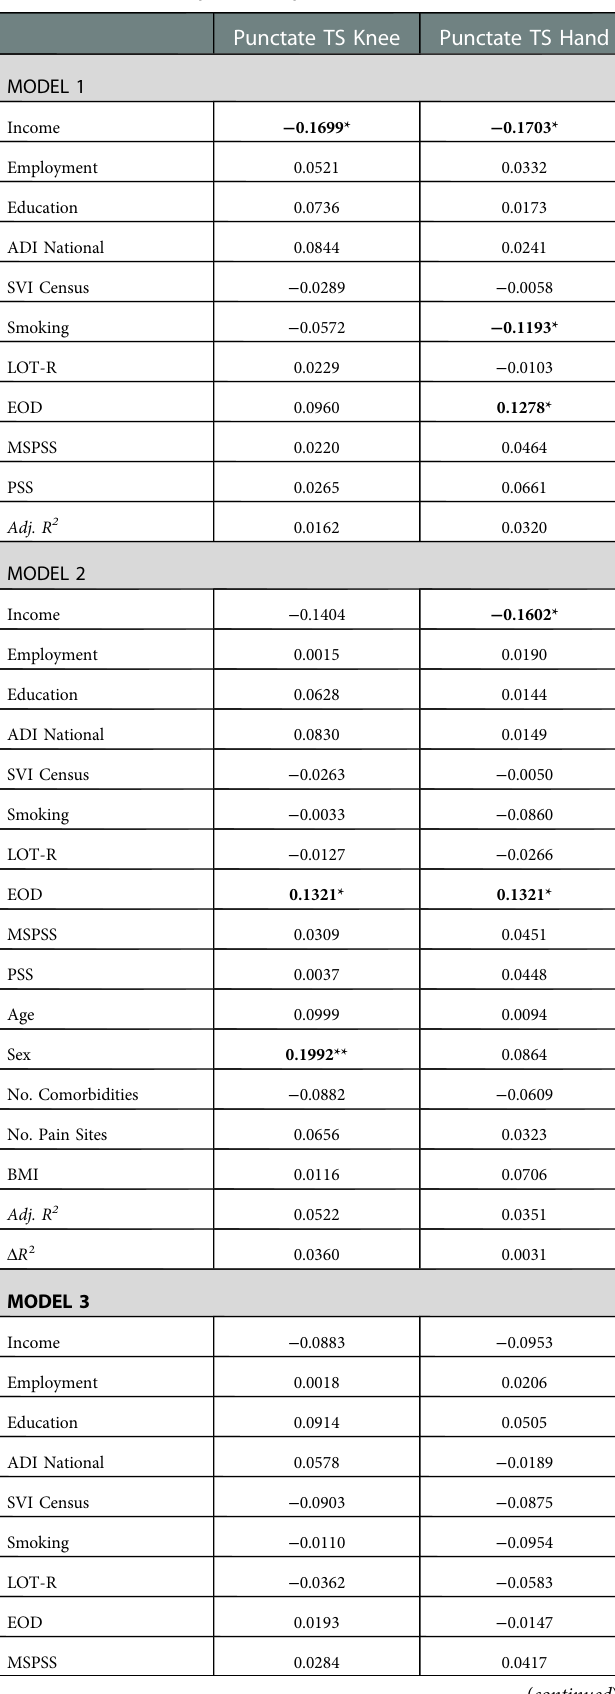
TABLE 4 Nested linear regression models assessing environmental and behavioral factors on experimental